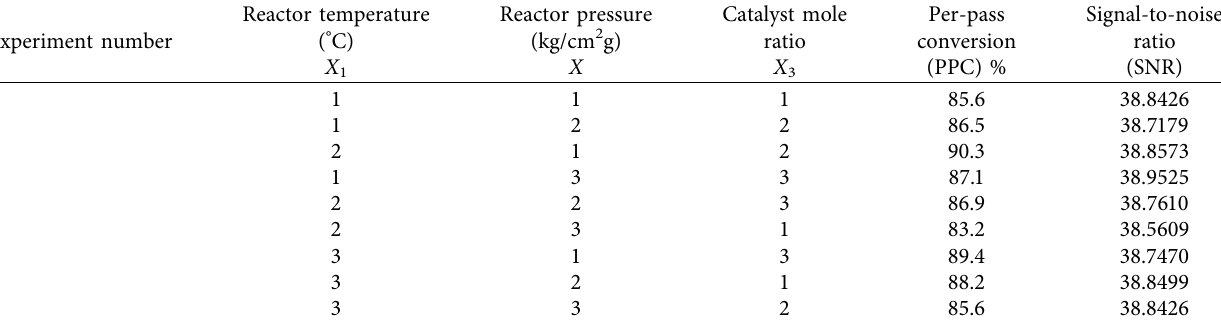
Table 3: Coded Taguchi L